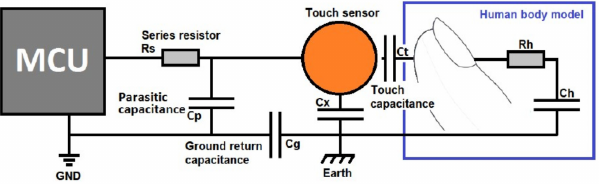
Figure 6. Circuit equivalence of a self-capacitance touch sensor with an approaching finger